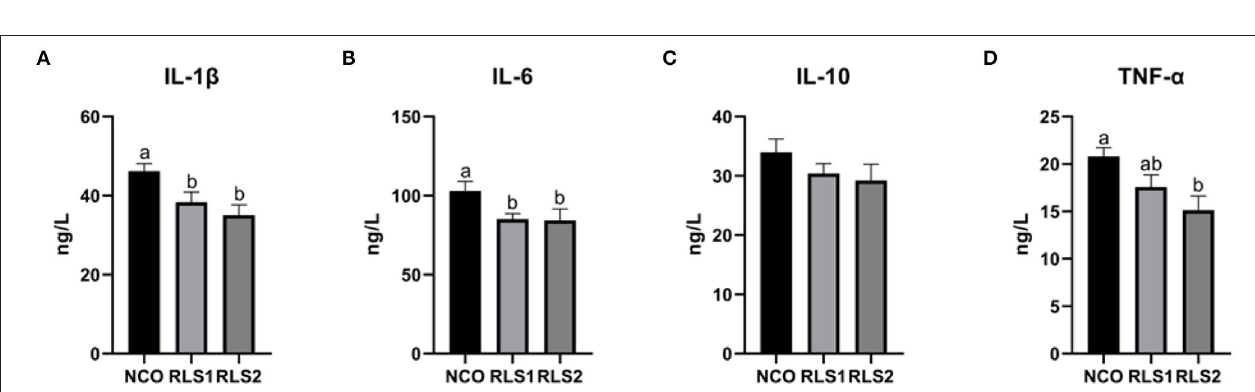
FIGURE 4 | Effects of RLS on serum inflammatory cytokine levels in rats. NCO, rats were gavage-fed normal saline; RLS1, rats were gavage-fed 10mg RLS / 200g body weight; RLS2, rats were gavage-fed 20mg RLS / 200g body weight. IL-1 β , interleukin-1 β ; IL-6, interleukin-6; IL-10, interleukin-10; TNF- α , tumor necrosis factor- α . Values are expressed as the mean ± SEM, n = 8. Different letters represent a significant difference of P < 0.05. Part labels represent standard error for the sample mean